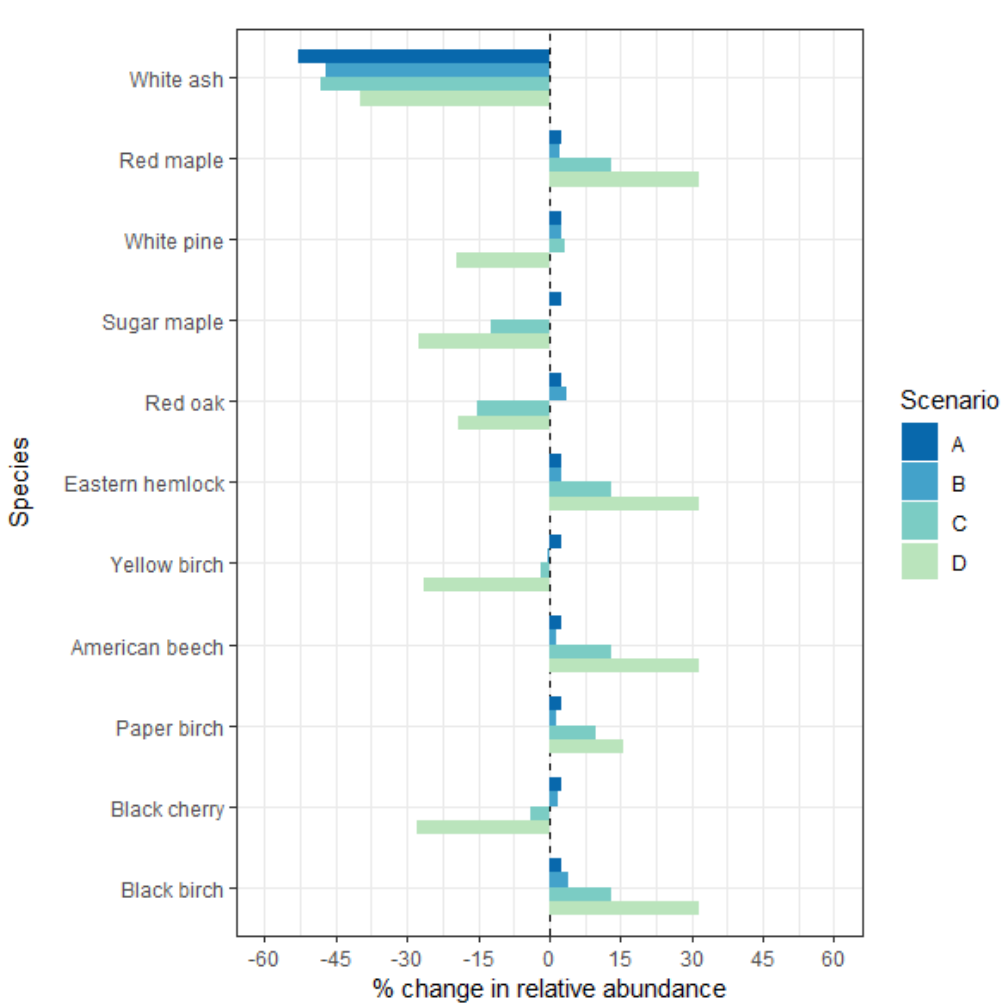
Figure 5. Change in relative abundance due to harvesting for the top 10 most abundant species in the Connecticut River Watershed for all FFO parcels in the watershed. 17